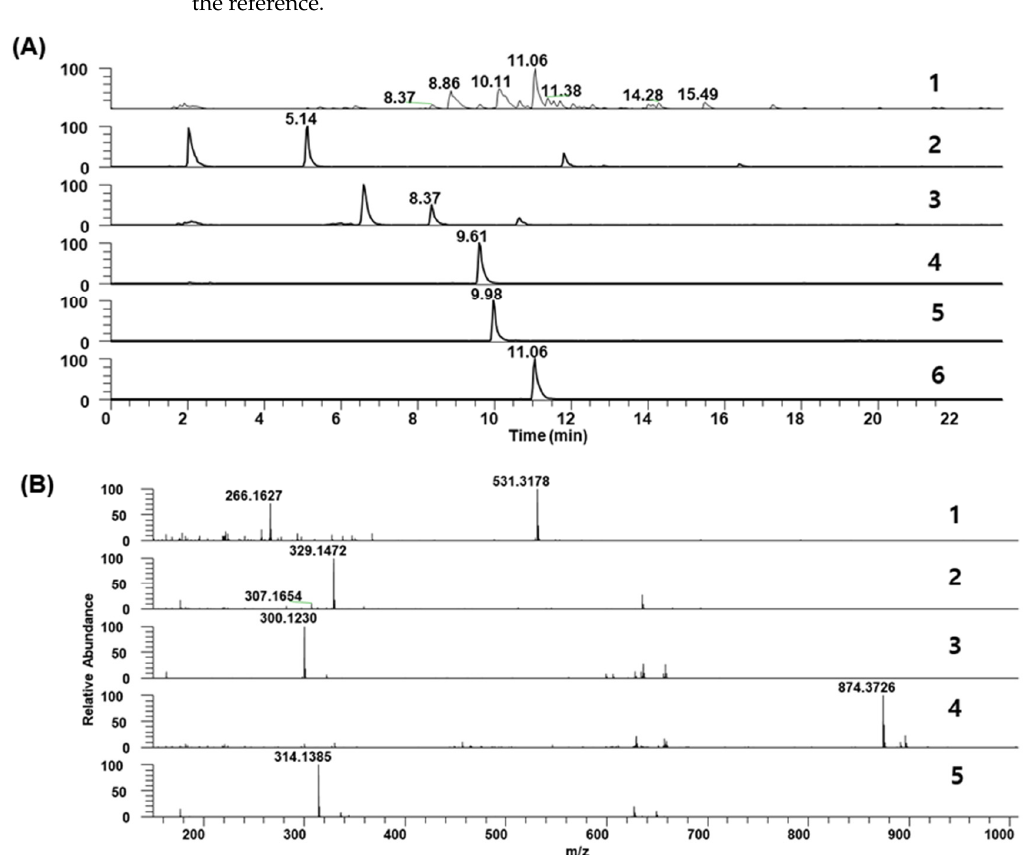
Figure 8. Identification of major anti-inflammatory compounds in GR30 by LC-MS analysis. ( A ) UHPLC chromatographic separation of compounds in GR30 and extracted ion chromatogram (XIC) of 5 compounds (P1~P5), eluted at RT of 5.14 min (P1), 8.37 (P2), 9.61 (P3), 9.98 (P4), and 11.06 (P5), respectively. ( B ) MS spectrum of P1~P5 compounds. Compounds were identified as kukoamine A or kukoamine B (P1), 4-[4-(tert-butoxycarbonyl)piperazin-1-yl]benzoic acid (P2), n -caffeoyltyramine (P3), lyciumin A (P4), and coumarin 314 (P5), respectively, based on the high-resolution mass spectrum and MS/MS production ions and summarized in Table 1. Table 1. Chemical profile of major compounds in GR30.